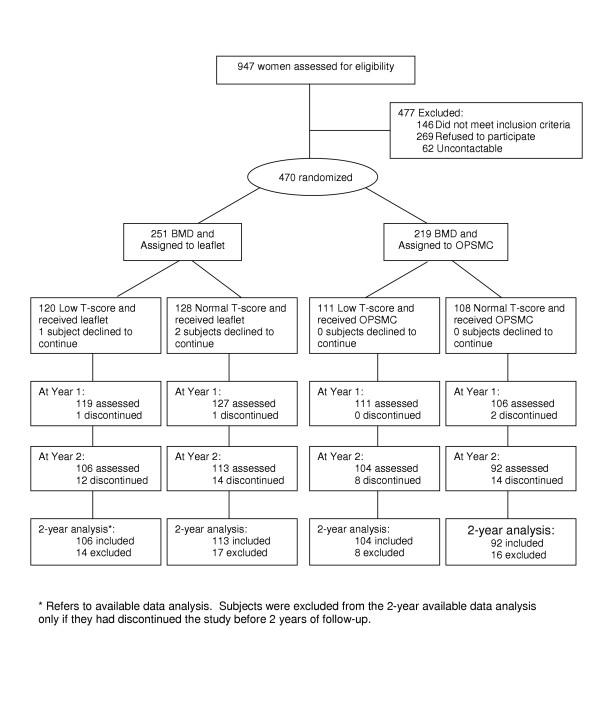
Flow of subjects through the trial.